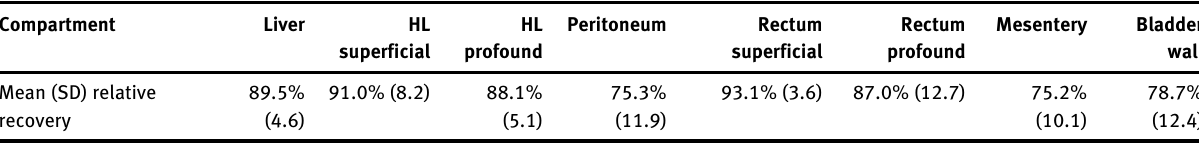
Table  : Mean (SD) relative recoveries shown for all compartments.